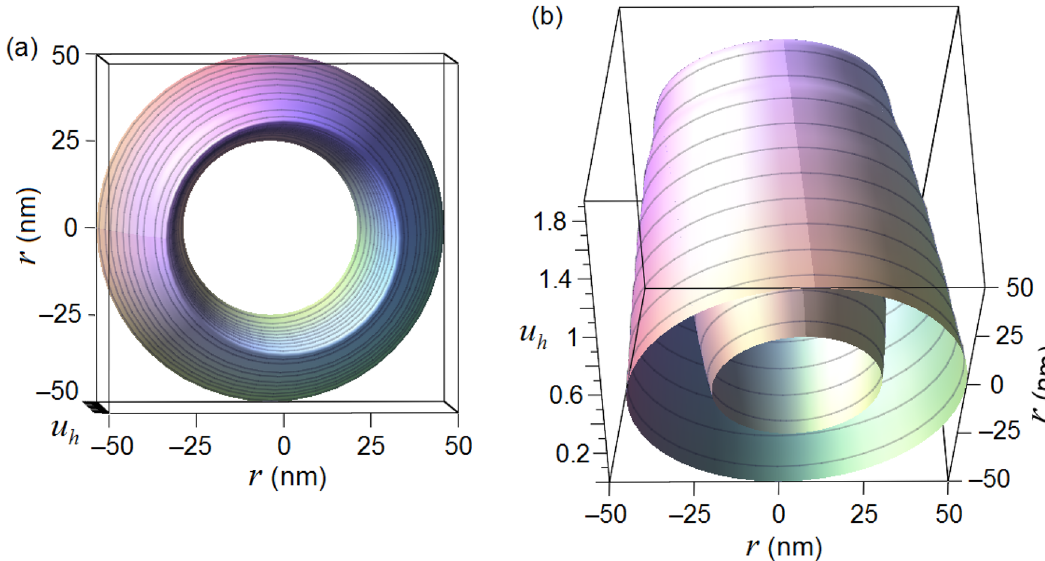
Figure 2. Ring spin isosurface (35) at the initial time t